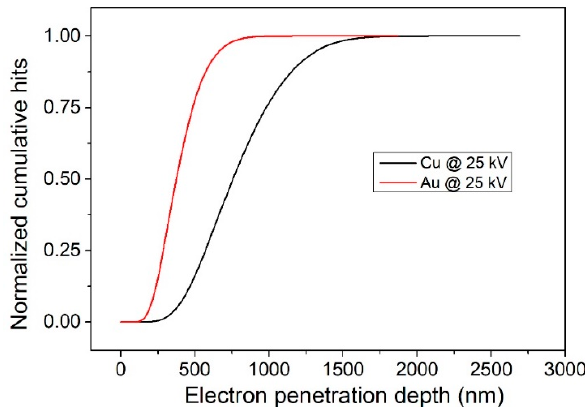
Figure 14. Penetration depth of electrons with an energy of 25 keV in copper and gold.